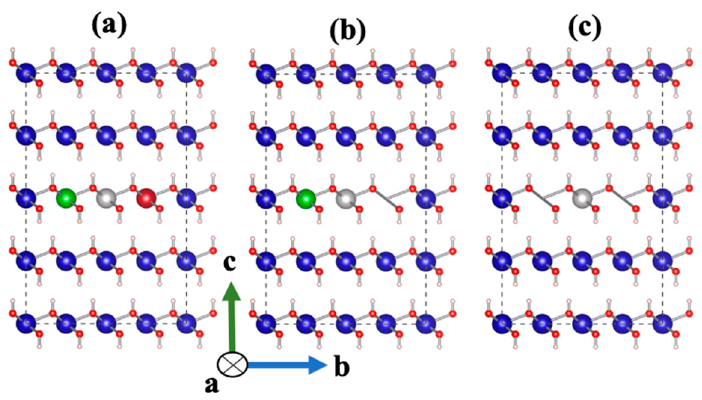
Figure 3. Illustration of three different scenarios for light gray Ca dissolution depending on the existing neighbors (in the presence of both left and right neighbors ( a ), in the presence of just left or right neighbor ( b ), in the absence of both left and right neighbors ( c )) on the 100 or 100 , 010 or 0 10 , and 110 or 1 10 facets of portlandite employing KMC upscaling approach.